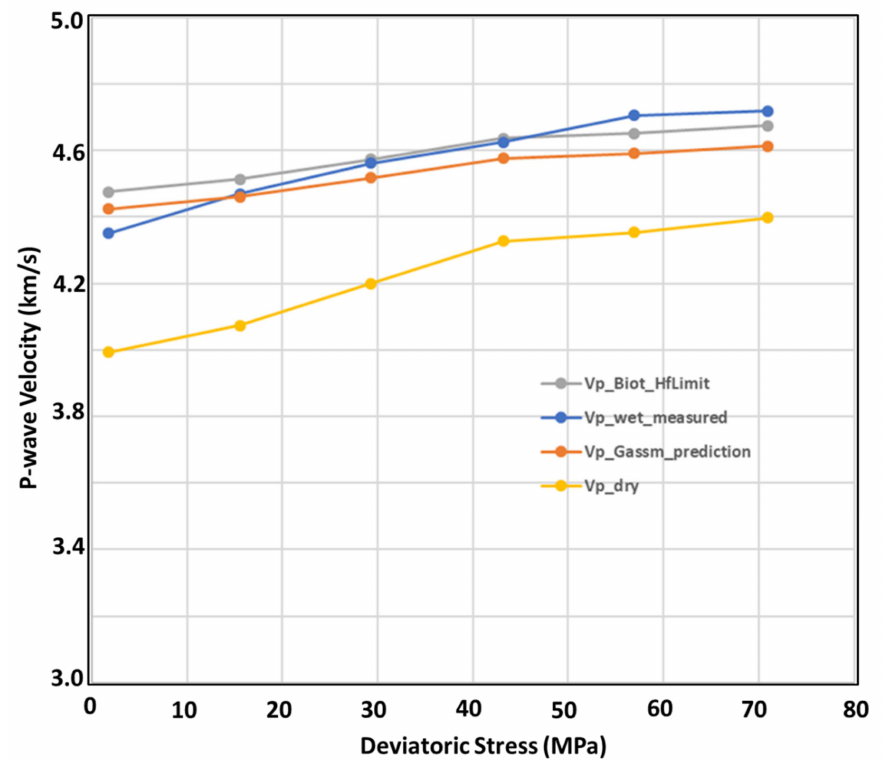
Figure 5. Plot of measured P-wave velocity on brine-saturated sample (blue), Biot P-wave velocity prediction (gray), Gassmann P-wave velocity prediction (orange), and measured P-wave velocity on dry sample (yellow) versus deviatoric stress. Confining pressure was held constant at 20.68